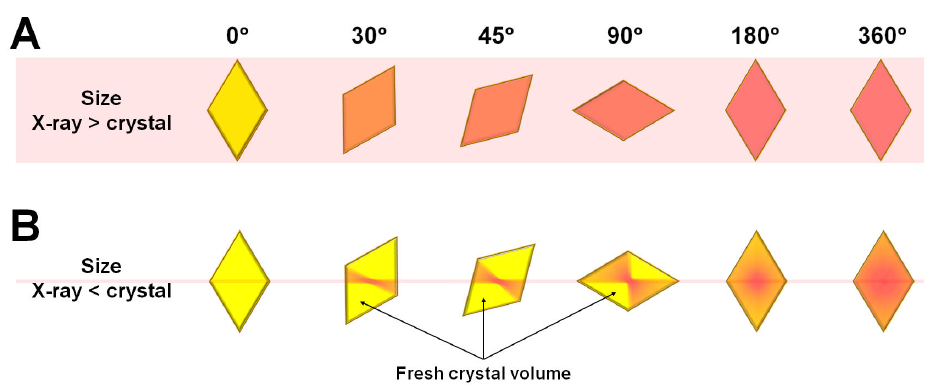
Figure 1. Schematic view of microfocused X ‐ ray beam path on crystals that are ( A ) smaller and ( B ) larger than the X ‐ ray beam.